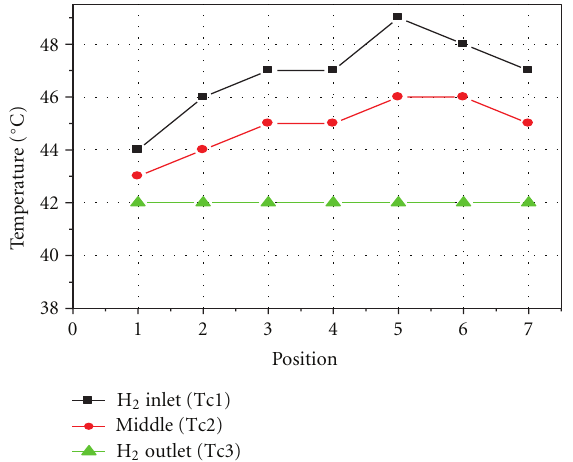
Figure 7: Temperature variation within the stack.